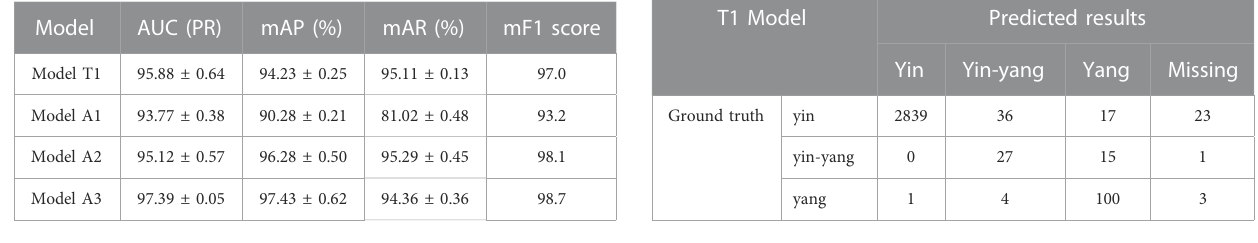
TABLE 3 The confusion matrix for cell classi fi cation generated by the T1 Model on the test